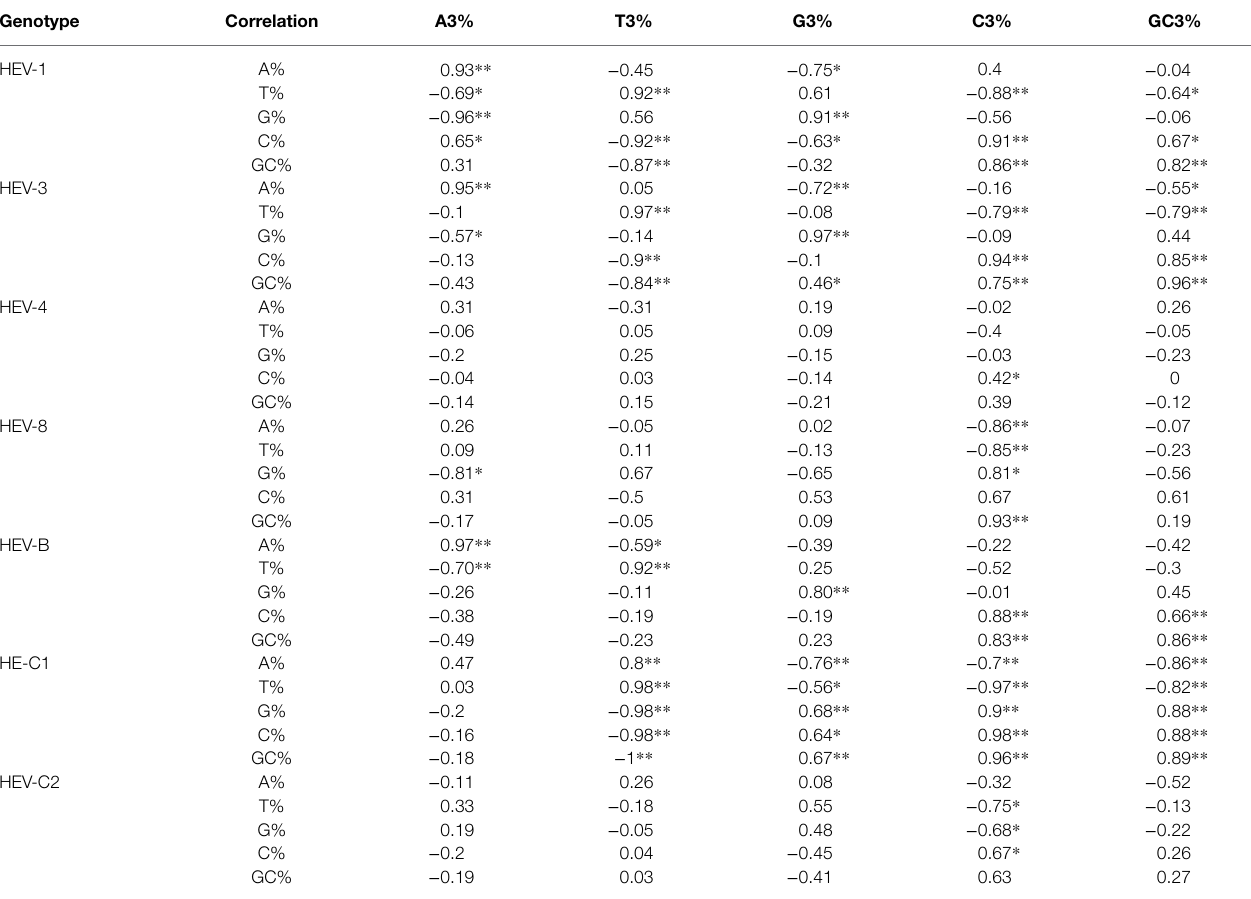
TABLE 2 | Correlation analysis between nucleotide composition and that at the third codon position of HEV complete coding sequences. Genotype